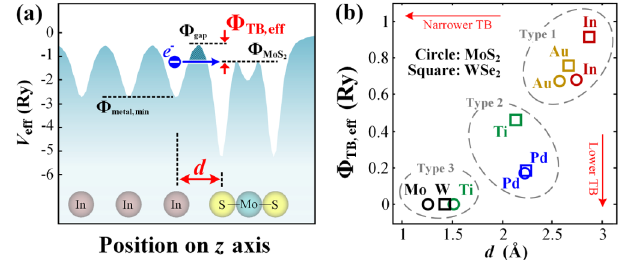
FIG. 10. Evaluation of the tunnel barriers at the contacts. (a) Plot of minimum effective potential ( V ) versus z position eff for In-MoS 2 top contact. Φ is the V of the Mo-S bond MoS 2 eff orbitals and thereby the effective tunnel barrier height ( Φ ) is TB ; eff defined as the minimum barrier height that an electron from the metal has to overcome if it has the same potential energy as Φ . Hence, Φ can be calculated as the V difference MoS 2 TB ; eff eff between the vdW gap ( Φ ) and MoS 2 ( Φ ). Φ gap MoS 2 metal ; min denotes the minimum V that an electron can have in the metal. eff It is worth noting that in some metals (such as Au) Φ can metal ; min be higher than Φ (thus, electron energy is always higher than MoS 2 is calculated that of Mo-S bond orbitals), in which case Φ TB ; eff ¼ Φ − Φ as Φ . Φ vanishes to zero when TB ; eff gap metal ; min TB ; eff Φ or Φ is higher than Φ . d is defined as the metal ; min MoS 2 gap physical separation (the z component of the nearest core-to-core distance between the metal atoms and the chalcogenide atoms). (b) Φ versus d plot for various top TB ; eff